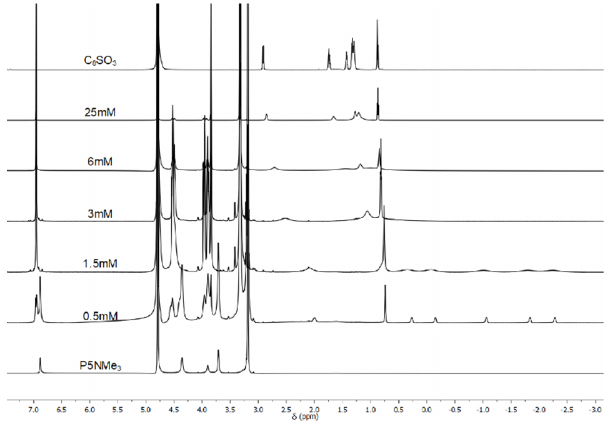
Figure 1. 1 H NMR spectra in D 2 O at 25 °C for pillararene (1.5 mM); octylsulfonate (1.5 mM) and mixtures of both with a constant concentration of pillararene (1.5 mM) and different concentrations of octylsulfonate.